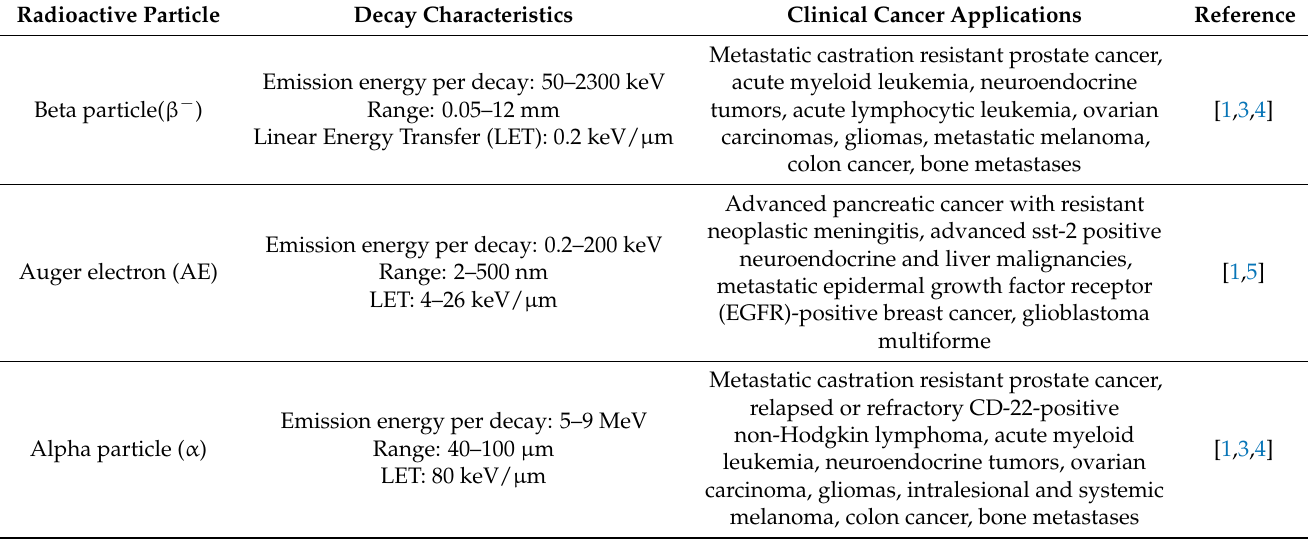
Table 1. Key characteristics of α , β − , and auger electron emitters and their clinical